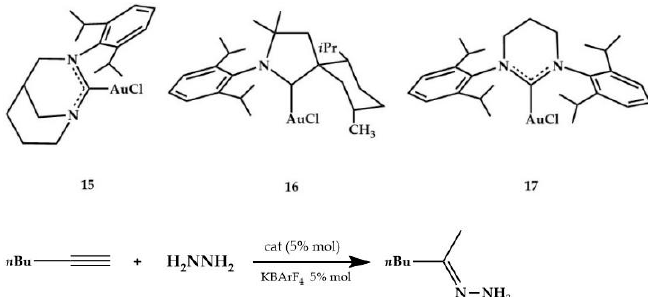
Scheme 5. Hydroamination of 1-hexyne with hydrazine. Table 3. Catalytic hydroamination of alkynes with hydrazine.